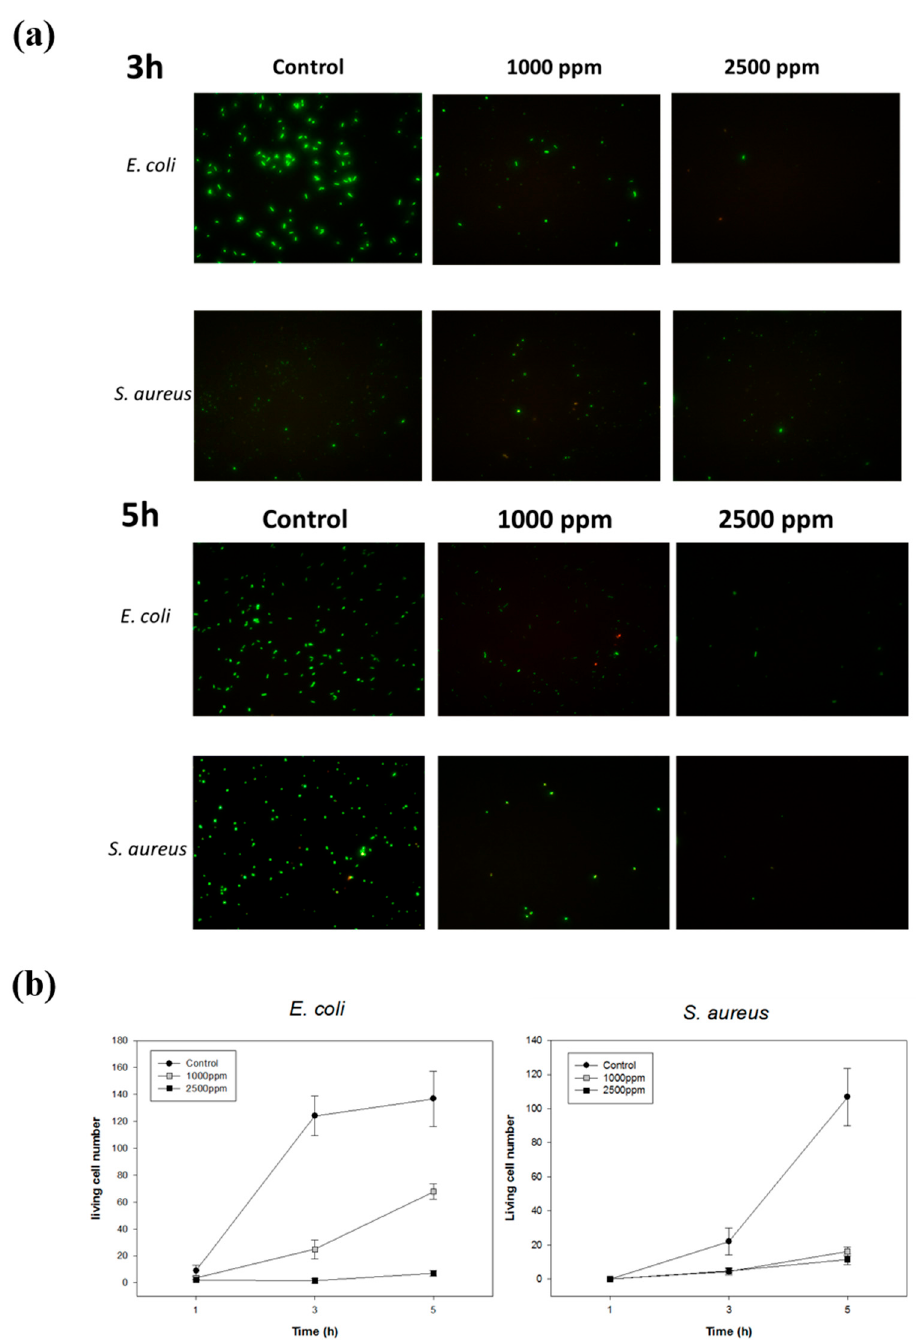
Figure 4. Inhibition of bacterial growth at different PS- b -PIN concentrations. ( a ) Fluorescence images and ( b ) the living number of E. coli and S. aureus with different PS- b -PIN concentrations treatment at 3 and 5 h.